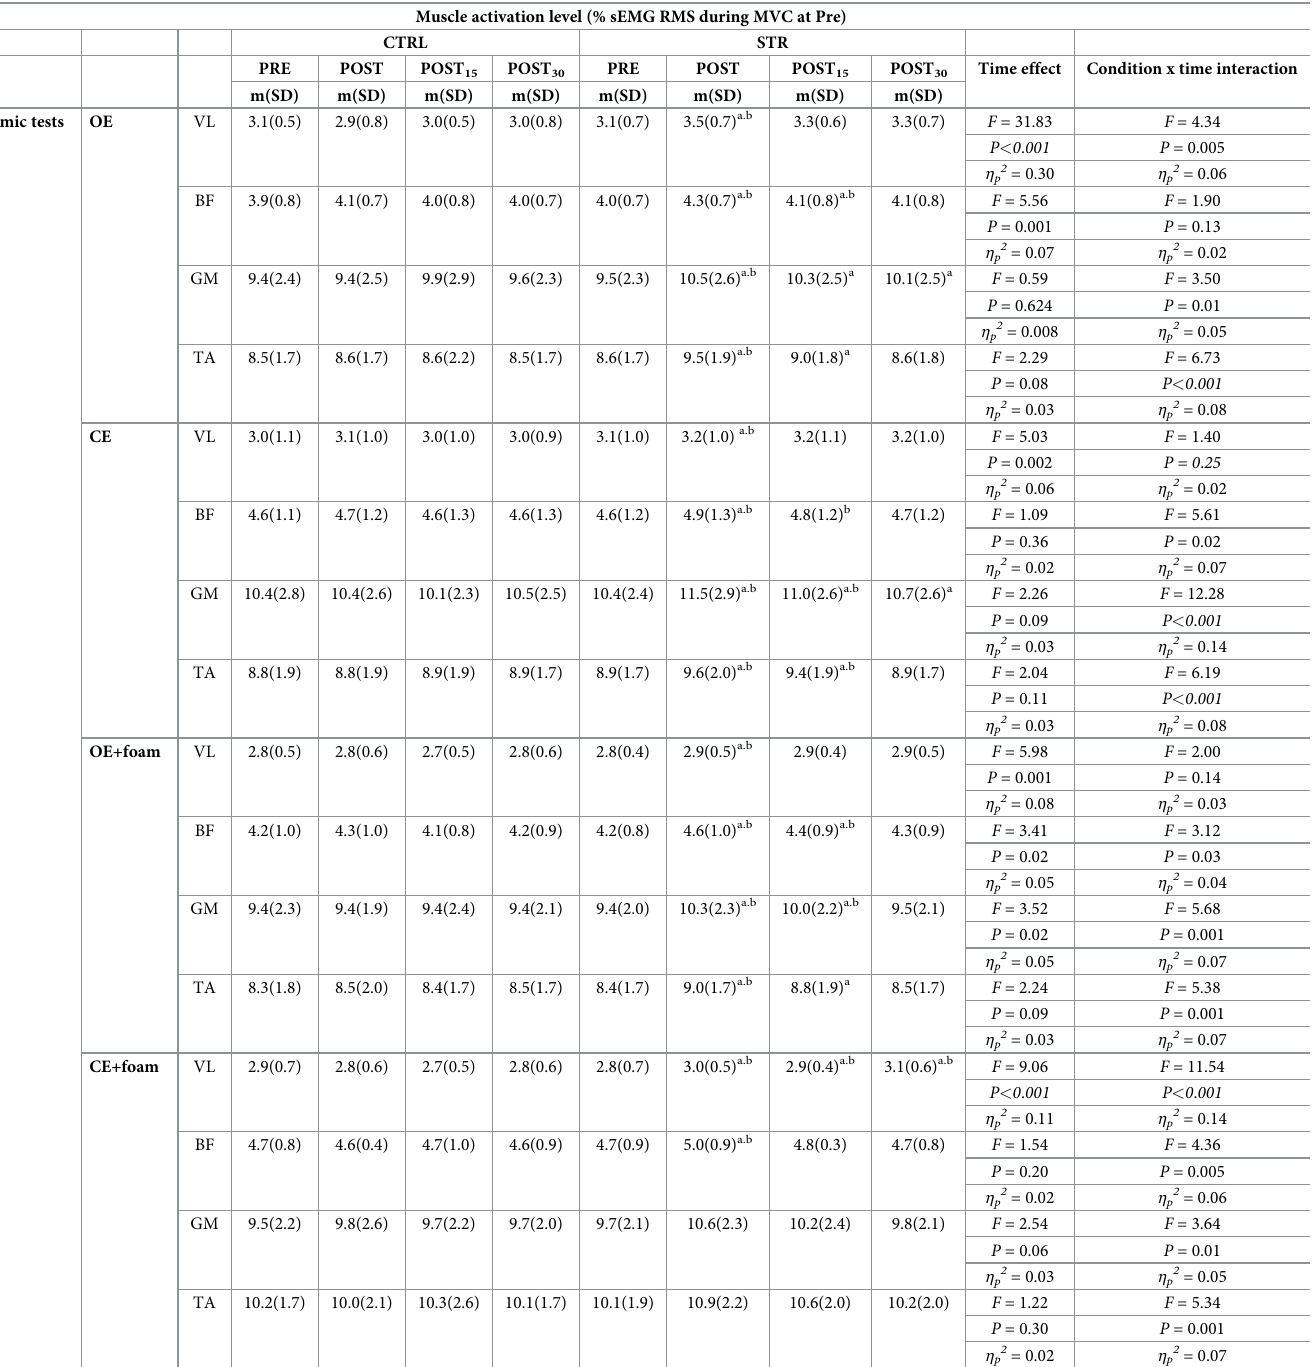
Table 7. Time course of percentage muscle activation in the control (CTRL) and stretching session (STR) during the dynamic